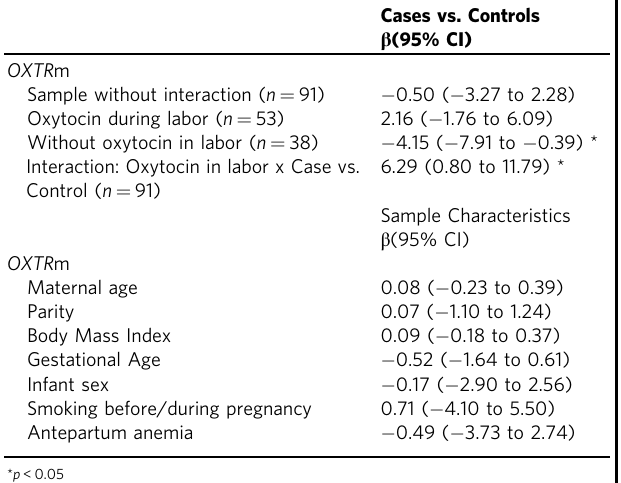
Fig. 3 Cases of postpartum hemorrhage had lower DNA methylation when labor was not stimulated by oxytocin. A Star denotes signi fi cant difference in total DNA methylation between cases of postpartum hemorrhage cases and controls among participants whose labor was not stimulated with oxytocin (red box plots, n = 38), z = 2.84, p = 0.003. B Difference in DNA methylation between postpartum hemorrhage cases and controls when oxytocin was used in labor (blue box plots, n = 53) z = − 1.86, p = 0.06. Whiskers denote + / − 1.5 x interquartile range. Table 2 Linear regression with interactions demonstrates Table 3 Greater total oxytocin administration associated higher OXTR m in postpartum hemorrhage cases when with higher OXTR m among individuals who needed oxytocin oxytocin was administered during labor and lower OXTR m for labor augmentation or induction of labor, parity and body when oxytocin was not needed in labor. mass also associated with oxytocin dosage in the multivariable